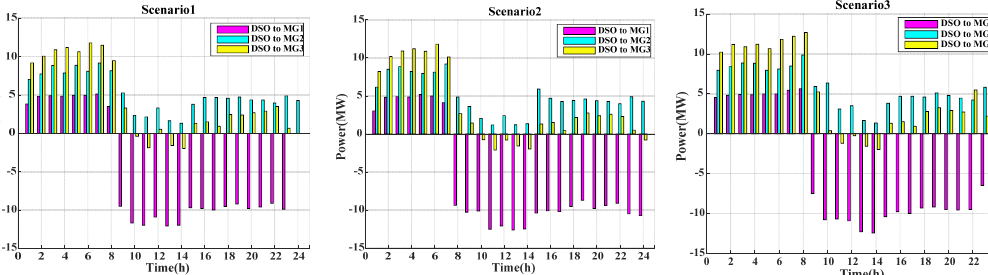
( b ) ( c ) Figure 12. Comparison of technical and financial results between: ( a ) CS1; ( b ) CS2 and ( c ) CS3. Total load profile of the system after load participation in DR program is shown in Figure 13. It can be seen that RLs are participated in DR programs through the bid-quantity offer packages in peak load periods to flatten the demand curve. Due to the increased retail and wholesale market prices in scenario 2, the amount of participated load in DR programs is increased. Particularly, the peak load has been decreased from 34.2 MW to 29.9 MW, 29.7 MW and 30.7 MW for scenario 1, scenario 2 and scenario 3, respectively.